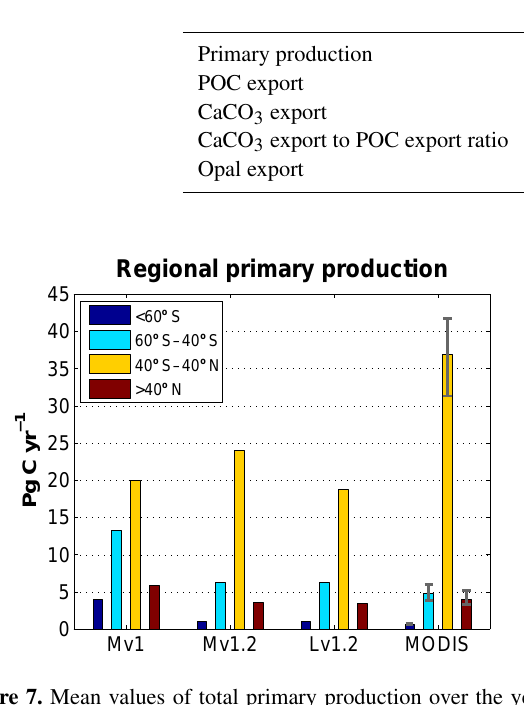
Figure 7. Mean values of total primary production over the years 2003–2012 simulated by the three model configurations and an es- timate of PP based on satellite data (mean of three climatologies derived from MODIS retrievals; see text) for the regions indicated in the inset. The grey bars indicate the range of observation-based